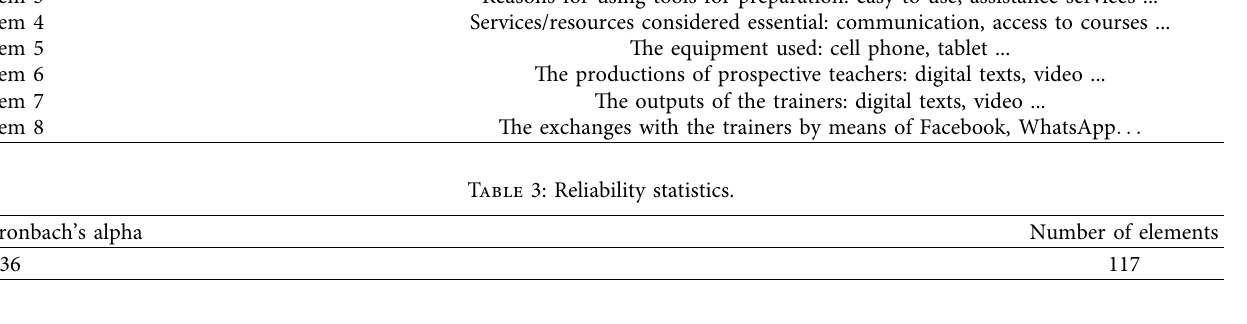
Table 4: Dominant digital practices among prospective teachers.